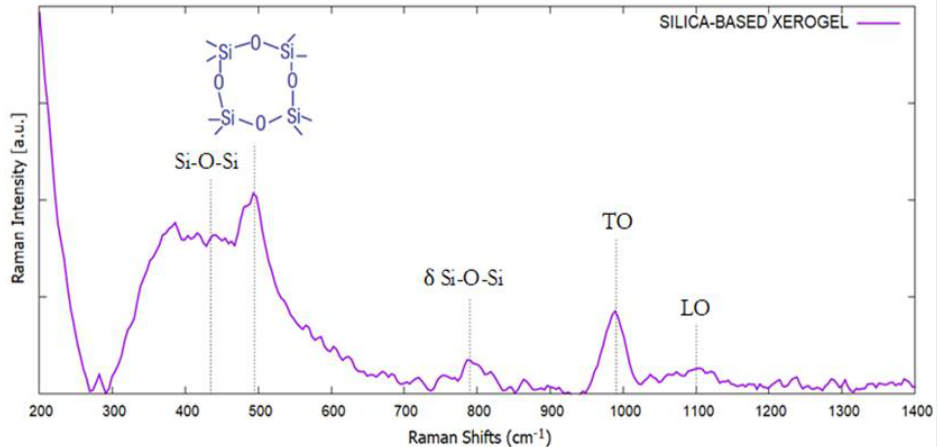
Figure 3. Raman spectrum of silica-based xerogel.